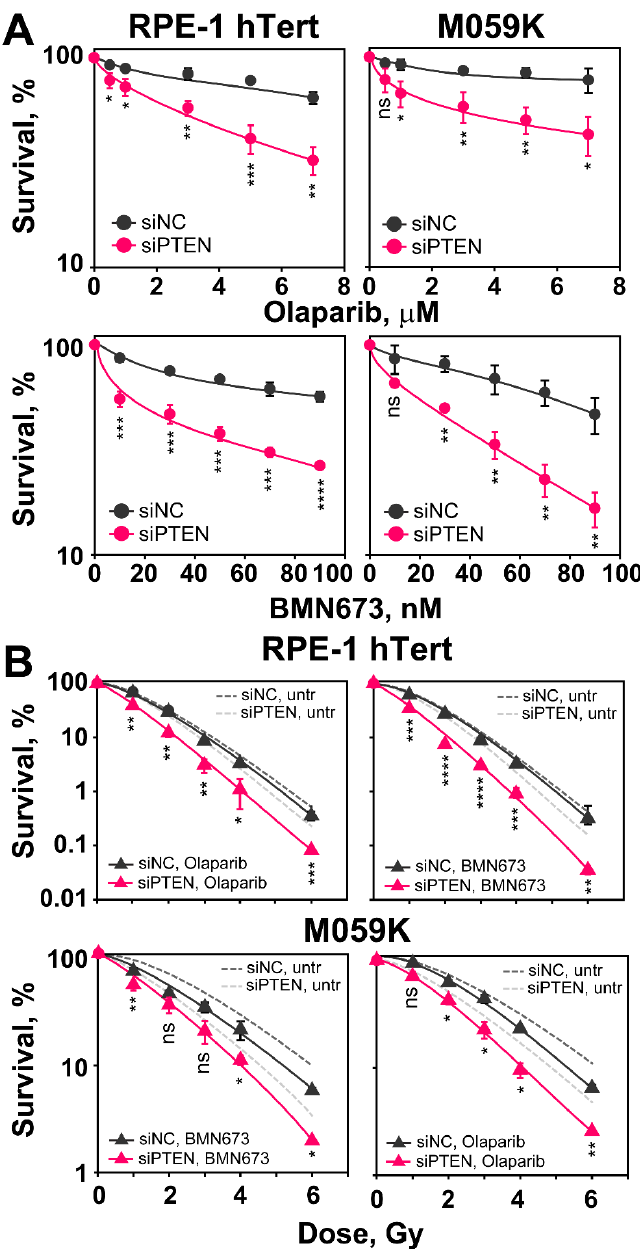
Figure 8. PTEN knock-down suppresses HR and renders non-irradiated and irradiated cells sensitive to PARPi, Olaparib and BMN673 . ( A ) Effect of Olaparib and BMN673 on the survival of RPE-1 hTert and M059K cells. Cells are treated with the indicated PARPi concentrations for 24 h. ( B ) Clonogenic survival assays of RPE-1 hTert and M059K cells exposed to increasing doses of X-rays and treated with PARPi (Olaparib — 3 μM or BMN673— 50 nM). Data show the mean ± SD from three independent experiments. The significance level, or p -value, is calculated using the two-tailed Student ´ s t -test: ns (not significant), * p < 0.05, ** p < 0.01, *** p < 0.001, **** p < 0.0001. Note that the significance of the observed effect is cell line